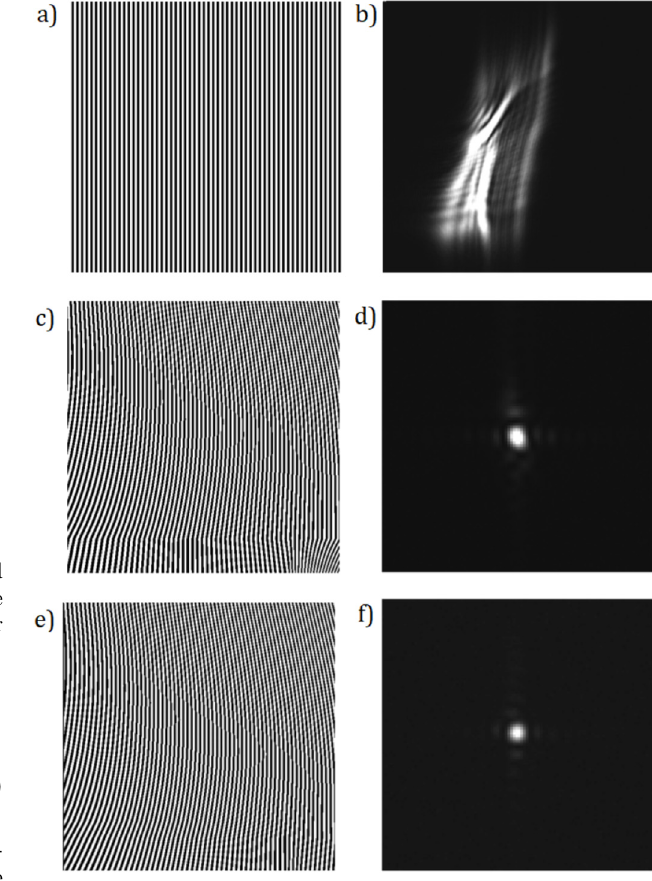
Fig. 8. Illustration of wavefront correction. Holograms projected on the DMD and corresponding patterns obtained on the Fourier plane: (a) and (b) without correction, (c) and (d) corrected after 1 iteration, (e) and (f) after 2